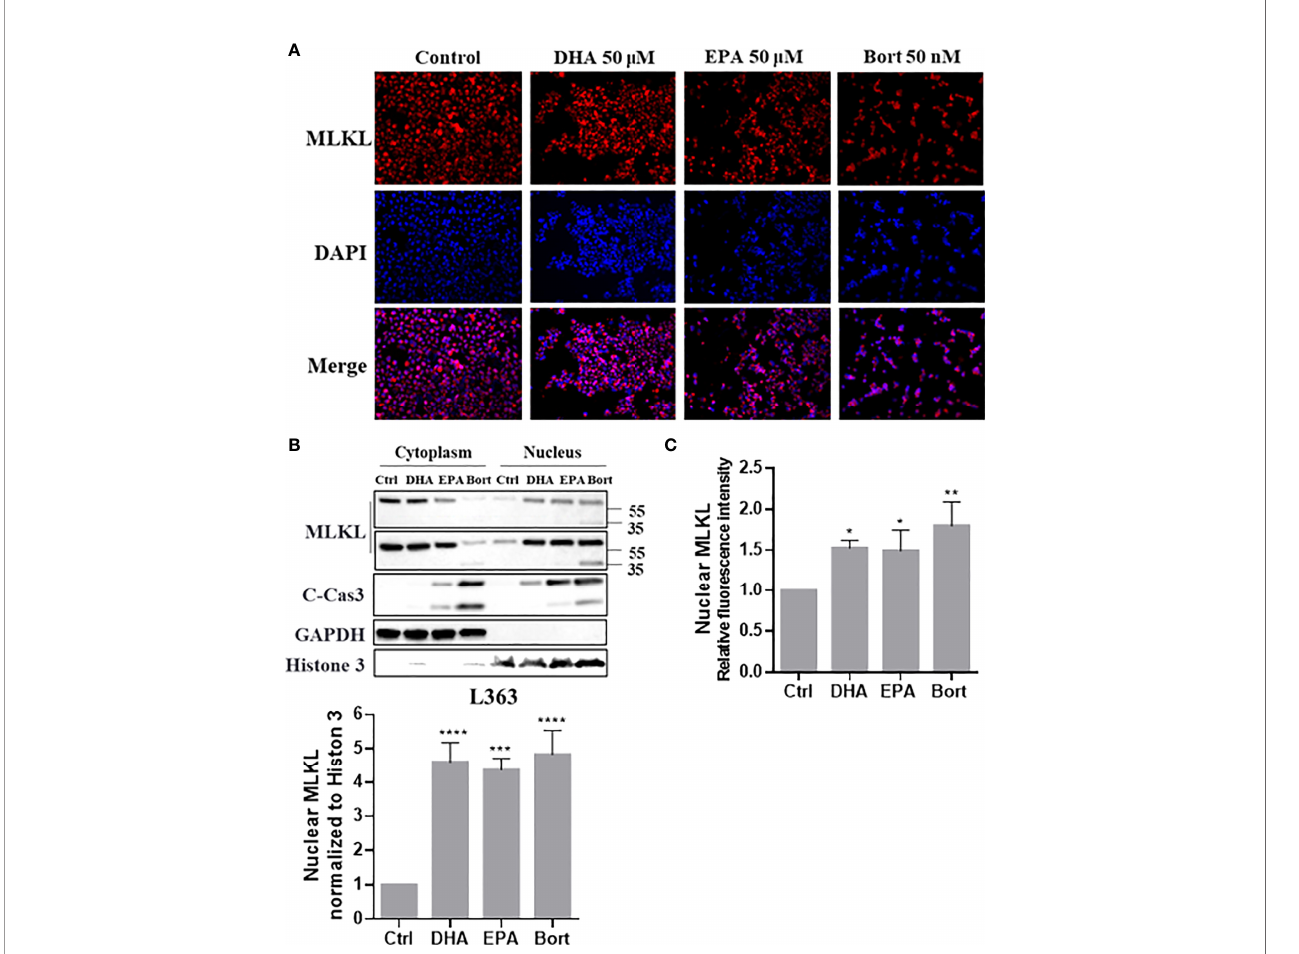
FIGURE 7 | Cell death triggers induce nuclear translocation of total MLKL and C-erminal MLKL in MM cells. L363 cells were treated with 50 µM of DHA/EPA or 50 nM bortezomib for 24 h. After treatment, (A) cells were stained with primary anti-MLKL antibody and AlexaFluor 594-conjugated secondary antibody (red) and the nucleus was stained with DAPI (blue). Then, stained cells were examined using a Fluorescence microscopy using speci fi c fl uorescence channel with 20x objective. The red MLKL and blue nucleus were merged to purple fl uorescence using Image J software. (B) Cytoplasmic and nuclear extracts were analyzed by western blotting using the indicated antibodies. (C) Quanti fi cation of (A) using Image J software. Data were expressed as mean ± SD of three independent experiments. * p < 0.05, * * p < 0.01, *** p < 0.001, **** p < 0.0001 when compared with